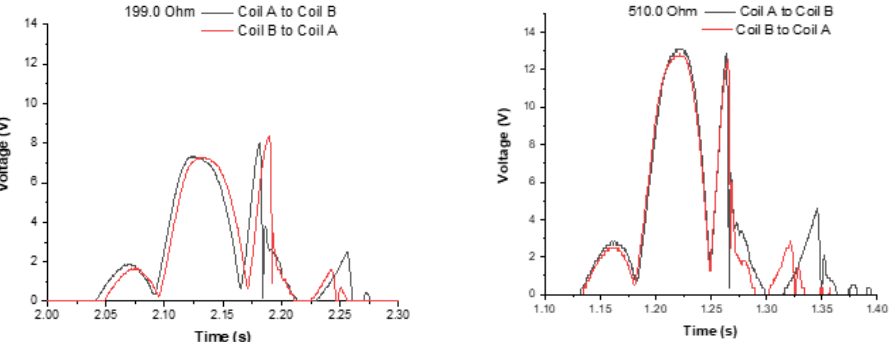
Figure 11. Measured output voltage in a freefall test, using several load resistors. Each graph shows voltage measured with movement from Coil A to Coil B and Coil B to Coil A. The ( left graph ) uses a load resistor of 199 Ω and the ( right graph ) a load resistor of 510 Ω .